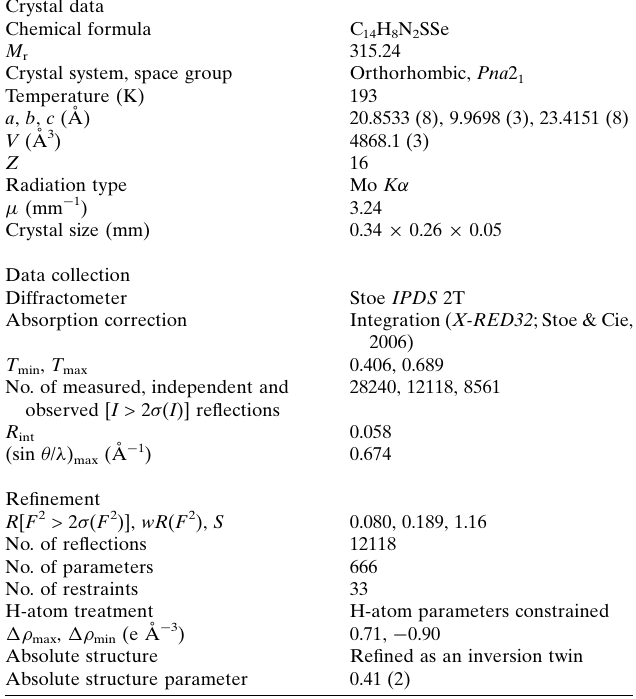
Table 1 Experimental